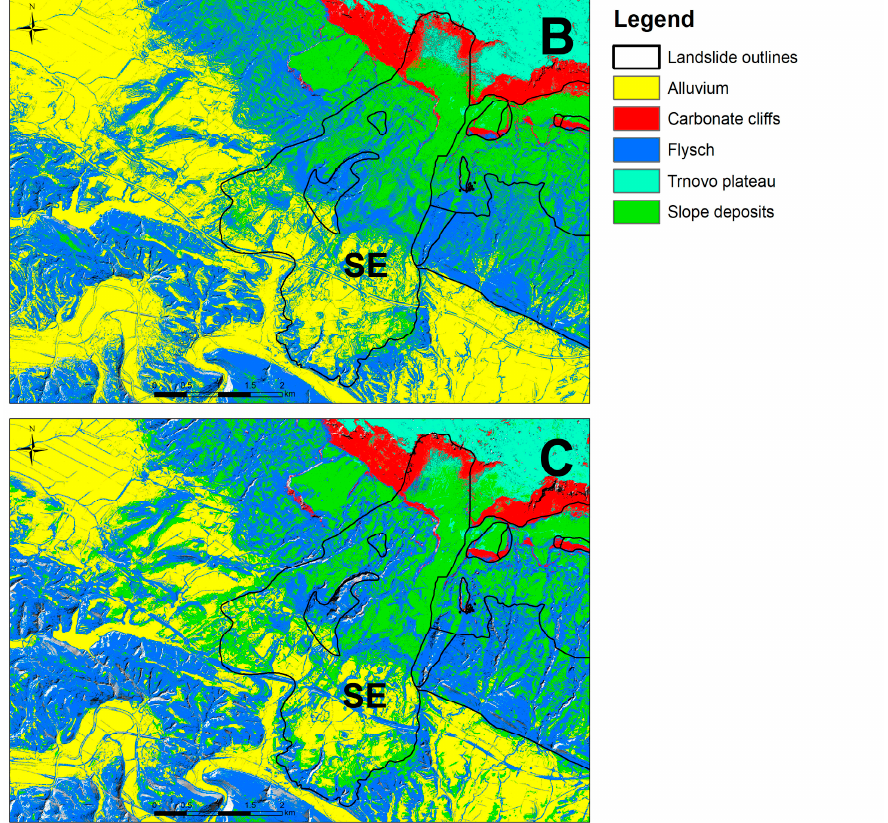
Figure 8. Selo landslide area. ( A ) outlines and main sediments of the litho-geomorphological units; ( B ) original MLC results; and ( C ) results from this study.